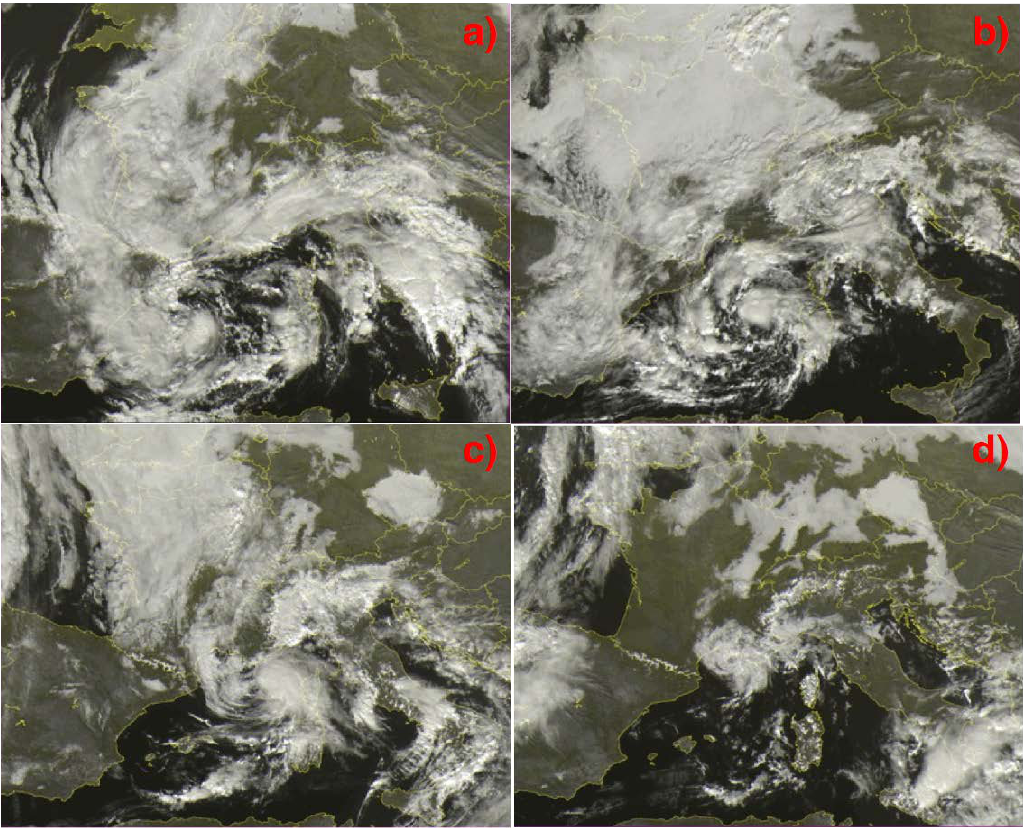
Figure 2. Visible channel of Meteosat Satellite images on 6 November 2011, 12:00 UTC (panel ( a )), 7 November 2011, 12:00 UTC (panel ( b )), 8 November 2011, 12:00 UTC (panel ( c )) and 9 November 2011, 12:00 UTC (panel ( d )) (source: www.sat24.com; copyright: EUMETSAT). In panel ( a ) we can see the formation of the TLC, whereas in the panel ( b ) the TLC is formed and in panel ( c ) ROLF is still well identified. In panel ( d ) the landfall of cyclone is shown.